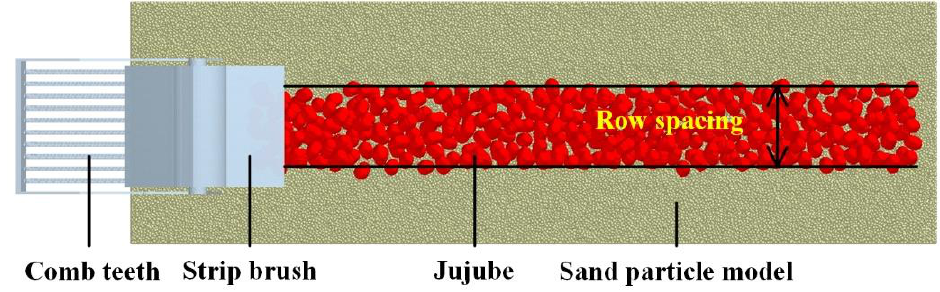
Figure 8. Simulation test model diagram.